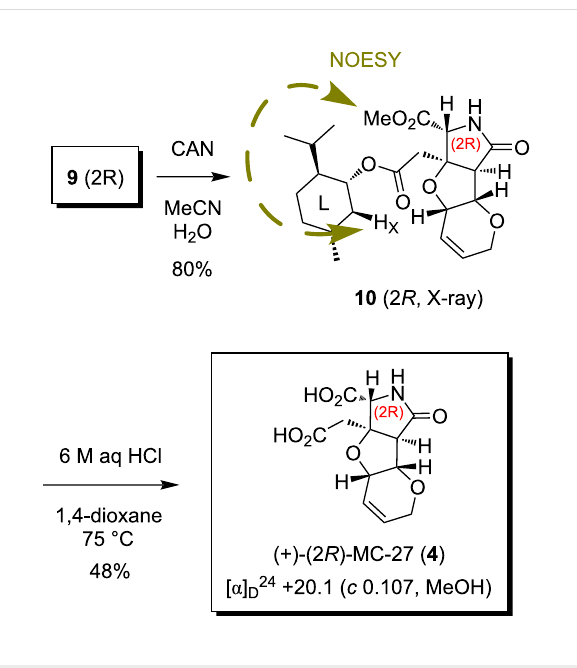
Scheme 3: Final elaboration of (2 R )-MC-27 ( 4